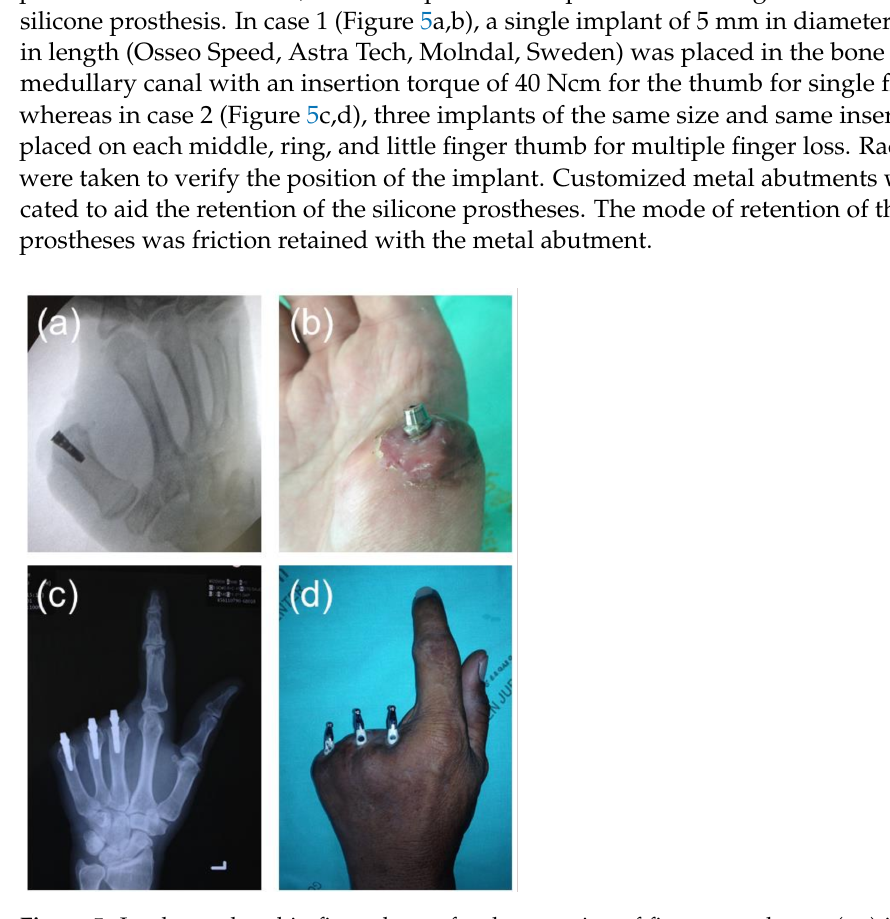
Figure 5. Implants placed in finger bones for the retention of finger prostheses: ( a , c ) implants in finger bones in an X-ray and ( b , d ) implants in finger bone